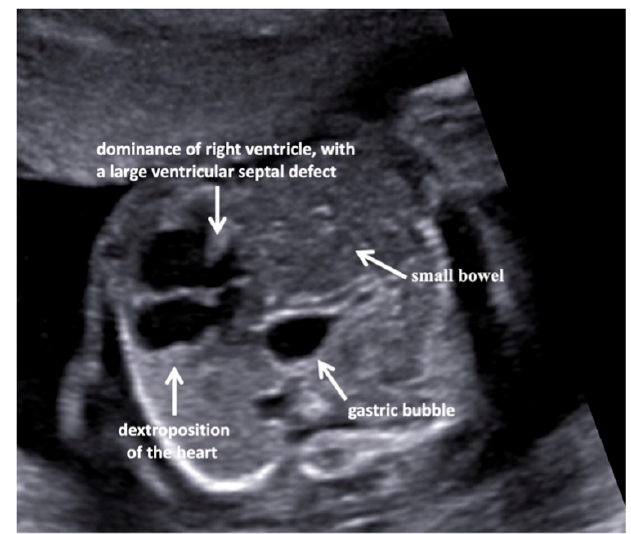
Figure 1. Axial view of the fetal thorax with dextroposition of the heart secondary to a diaphragmatic hernia on the left, at 20 weeks of pregnancy. The four-chamber view shows a dominance of the right ventricle, with a large ventricular septal defect. The gastric bubble is just behind the heart. The small bowel is visible within the left chest.